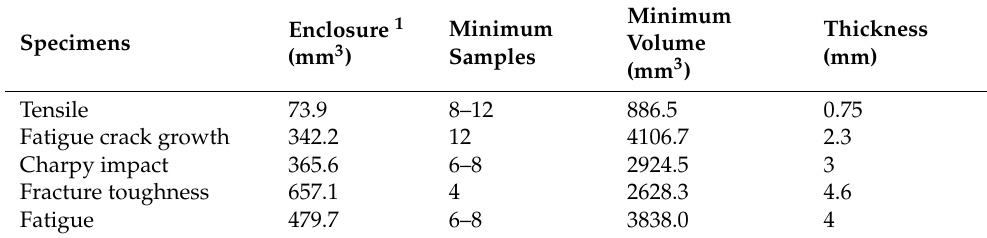
Table 1. The geometry features of the specimens.